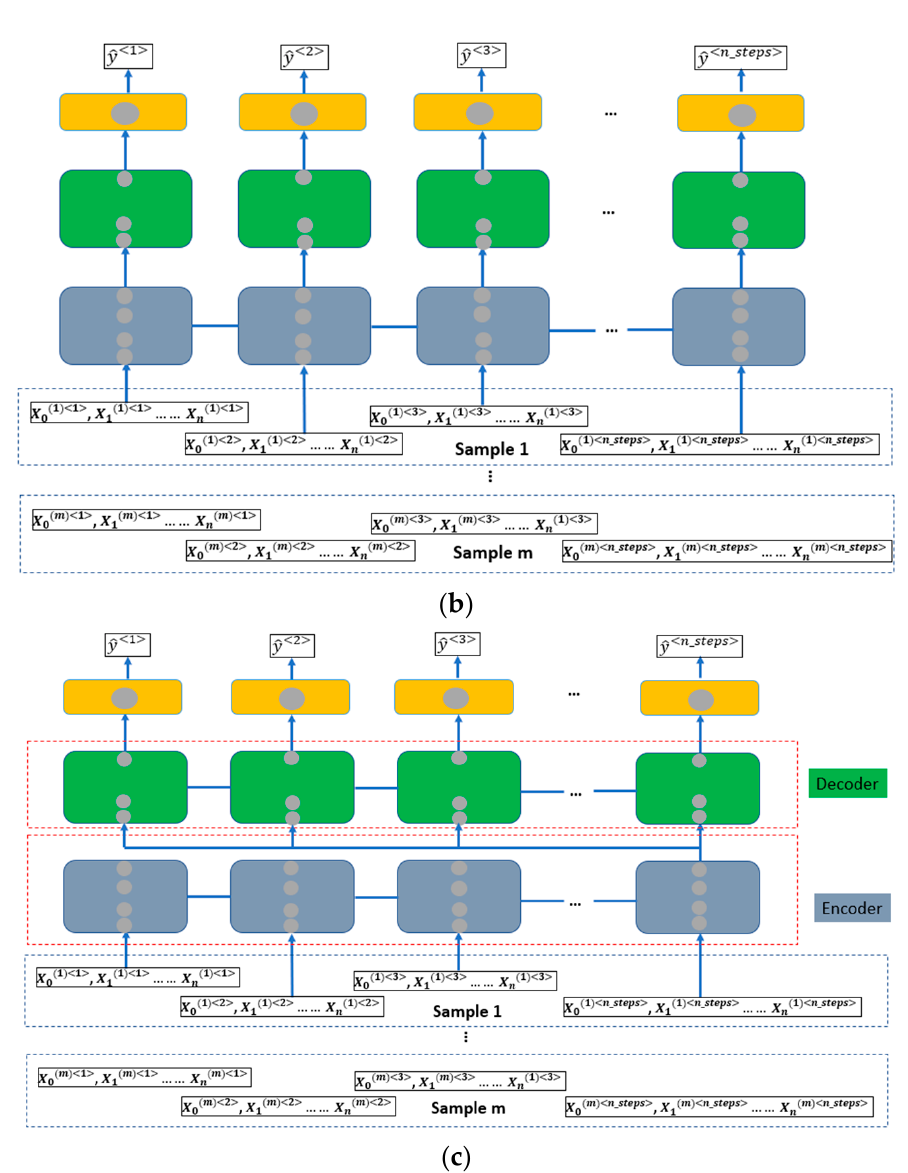
Figure 5. The appropriate RNN model architectures for traffic noise modelling, based on Blansko data: ( a ) Many-to-one architecture: sequence input and single output. ( b ) Many-to-many architecture: synced sequence input and sequence output. ( c ) Encoder–decoder architecture: sequence input and sequence output (not necessary to be synced).